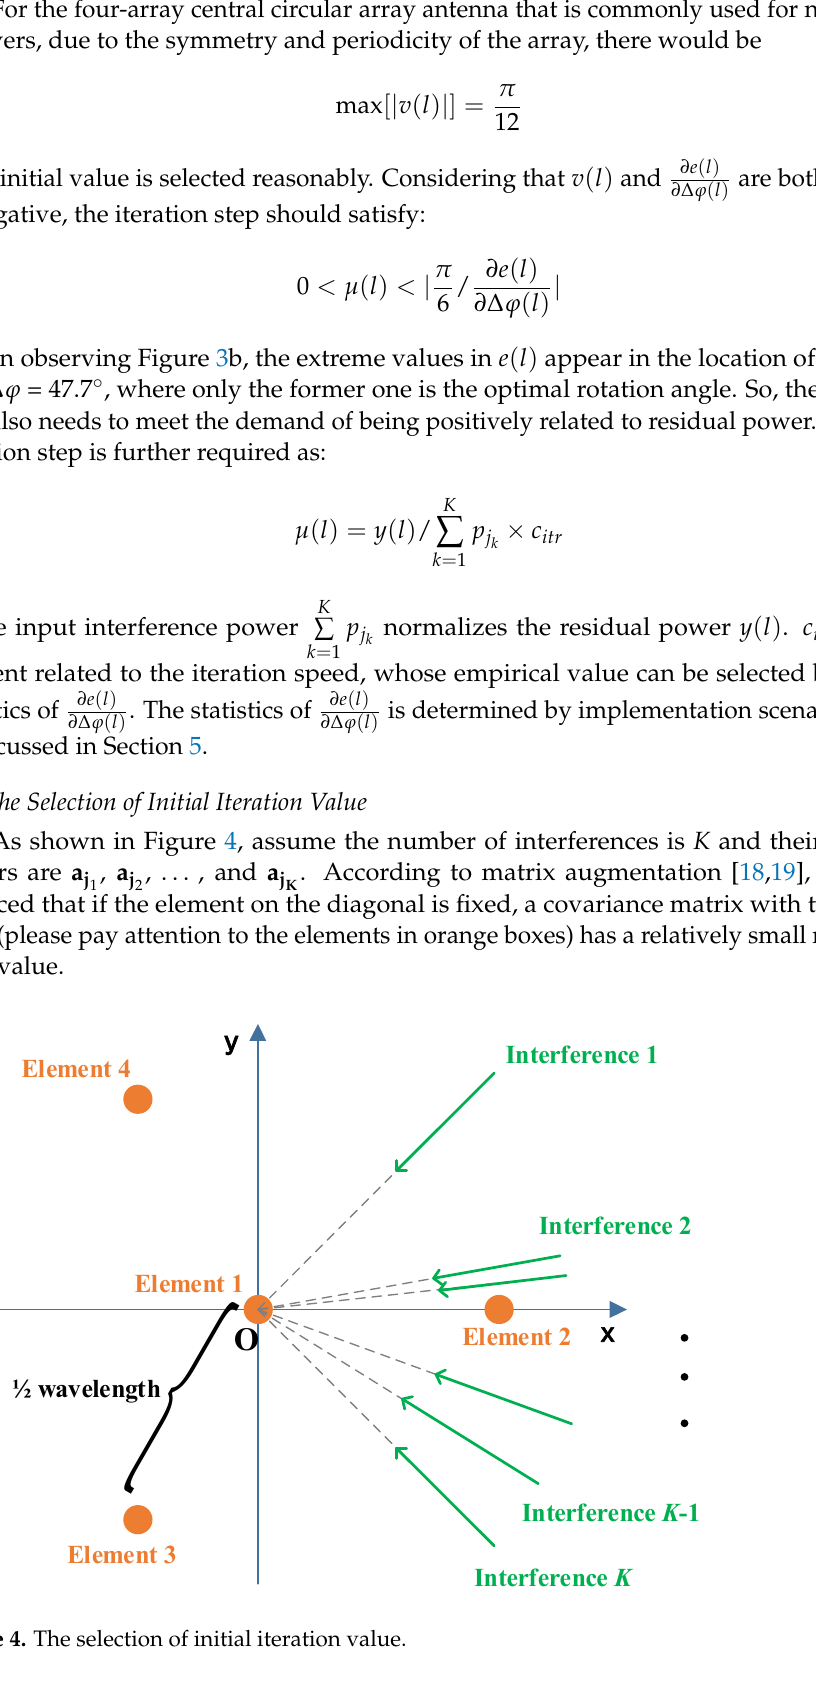
Figure 4. The selection of initial iteration value.